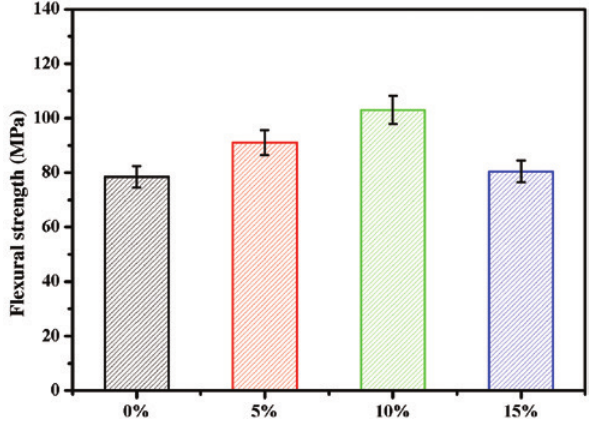
Figure 7: Flexure strength of BAPh/PEN-OH polymers cured at 300 ° C.